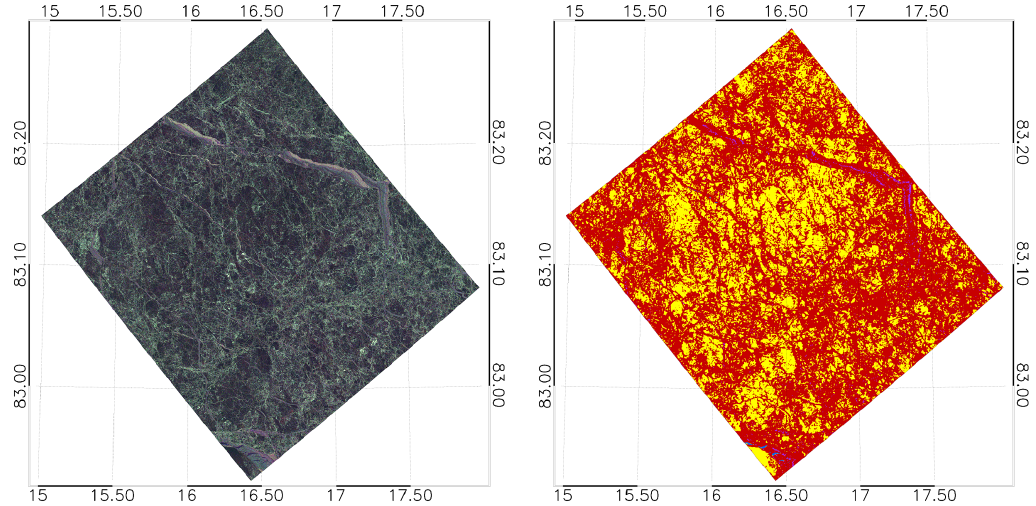
Figure A9. ( Left ) Geocoded Pauli RGB composite (Red: HH-VV Green: HV+VH Blue: HH+VV) of the RS-2 acquisition on 19 April 2015, frame 1; ( Right ) ice classification. Blue: open water/nilas (OW), purple: young ice (YI), yellow: first year ice (SFYI), red: rough first year ice/multi-year ice